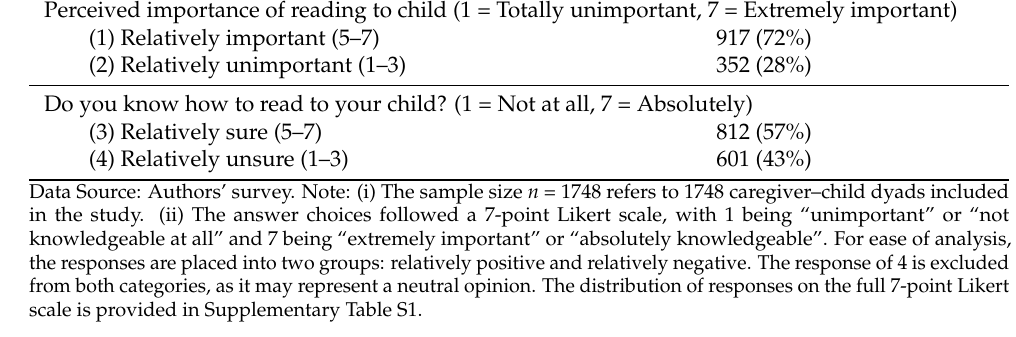
Table 3. Perceived importance and knowledge of reading practices among caregivers ( n = 1748). Variable n